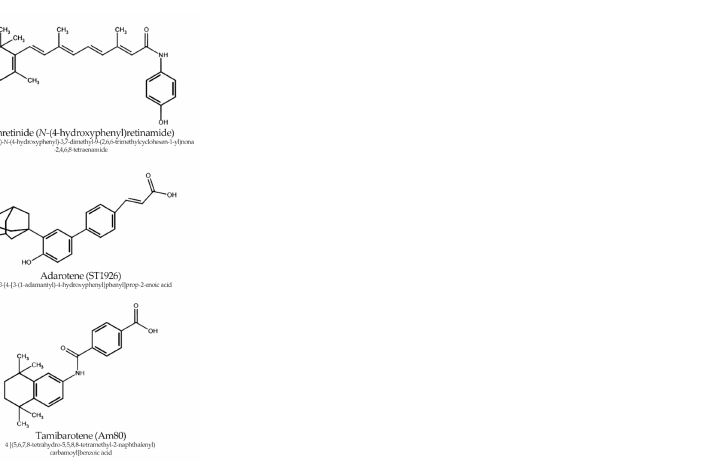
Figure 1. The chemical structure of ATRA and synthetic retinoids that were the main subjects of investigation in the last decade of research regarding prostate